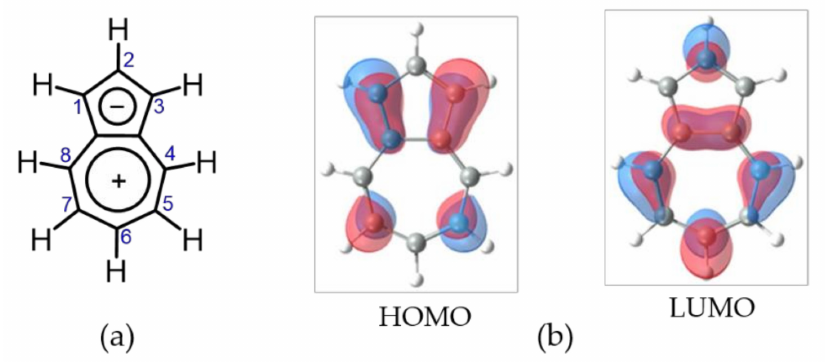
Figure 1. ( a ) Zwitterionic resonance form of azulene and the atom numbering scheme for the azulenic framework; ( b ) Highest Occupied Molecular Orbital (HOMO) and Lowest Unoccupied Molecular Orbital (LUMO) of